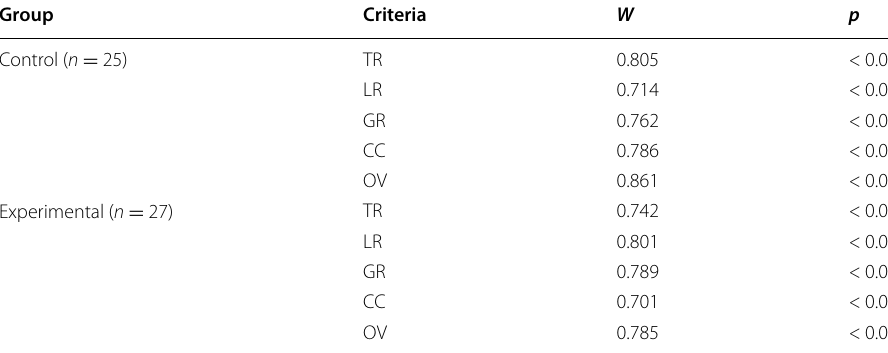
Table 2 Distribution of data of the